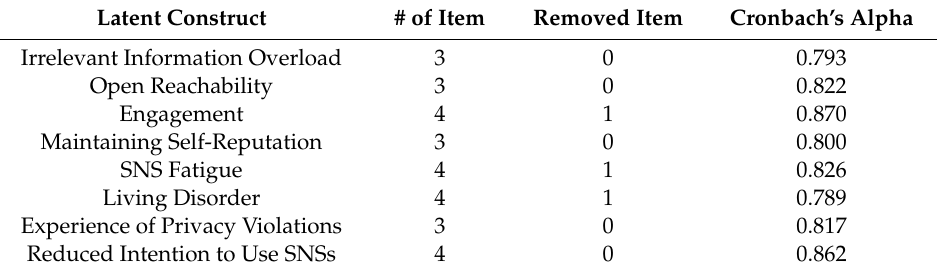
Table 4. Reliability testing